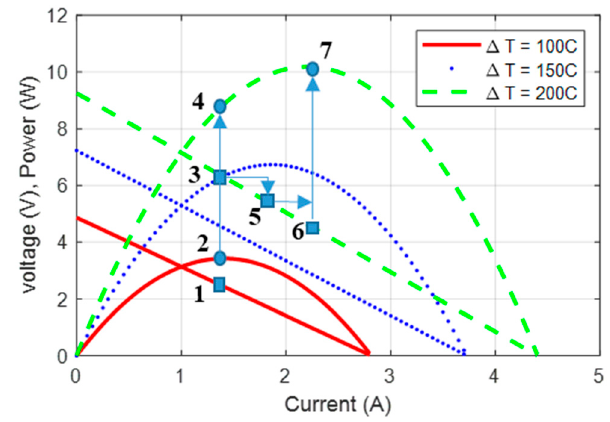
Figure 3. Proposed maximum power point tracking (MPPT) algorithm principle.